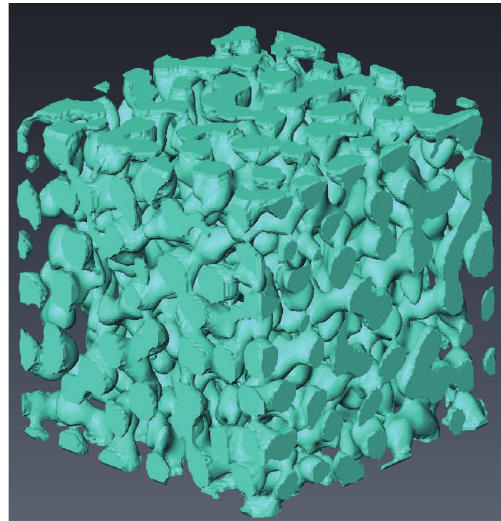
Figure 10. The inside spheroidal cavities of the biological